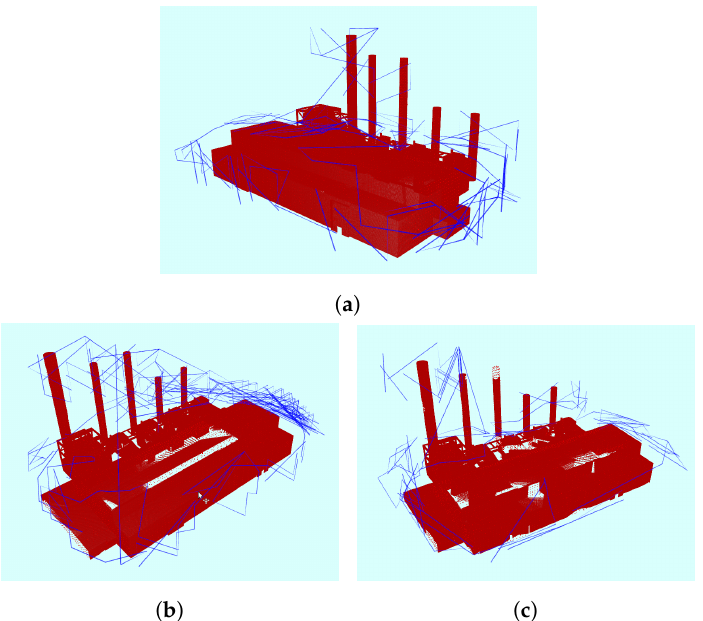
Figure 10. The path followed by the UAV in simulation around the power plant structure using three